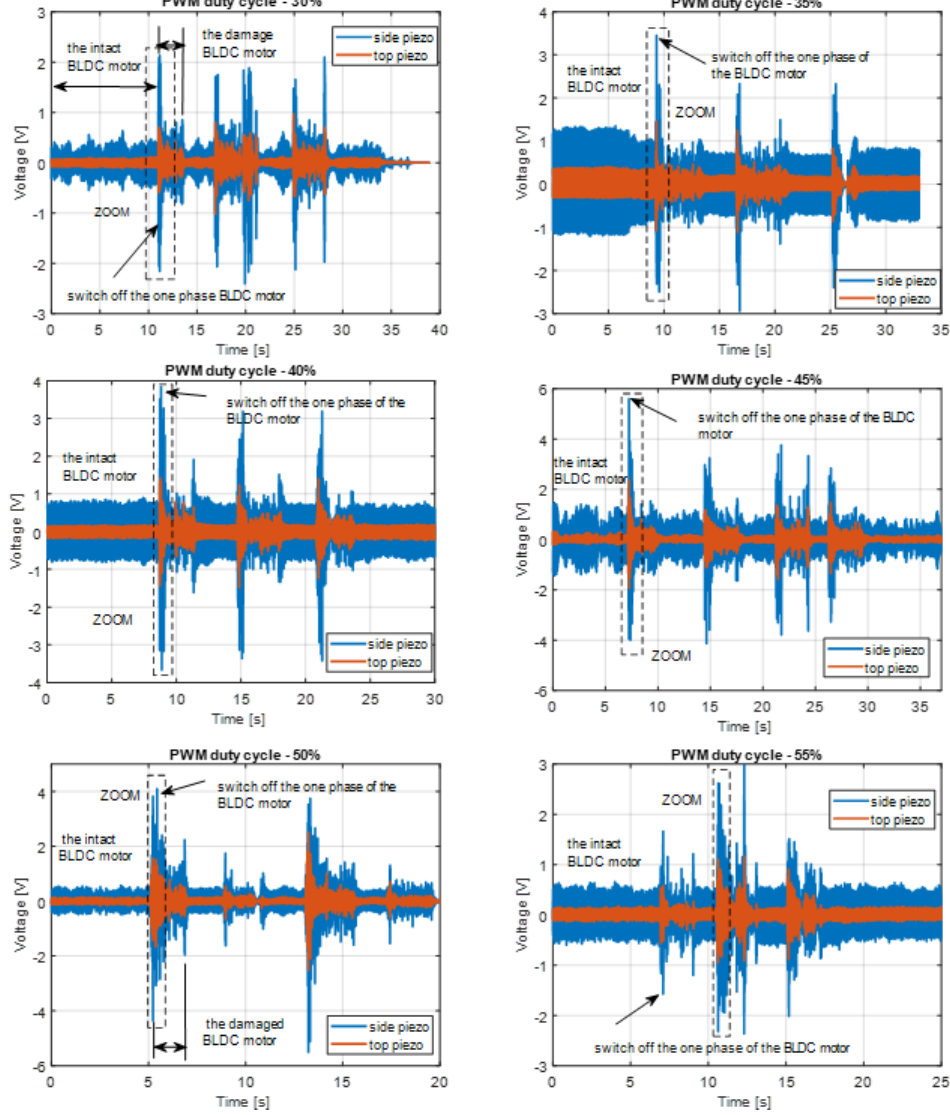
Figure 12. The comparison of voltage generated by the top piezo sensor and the side piezo sensor by various values of the PWM duty cycle in the range